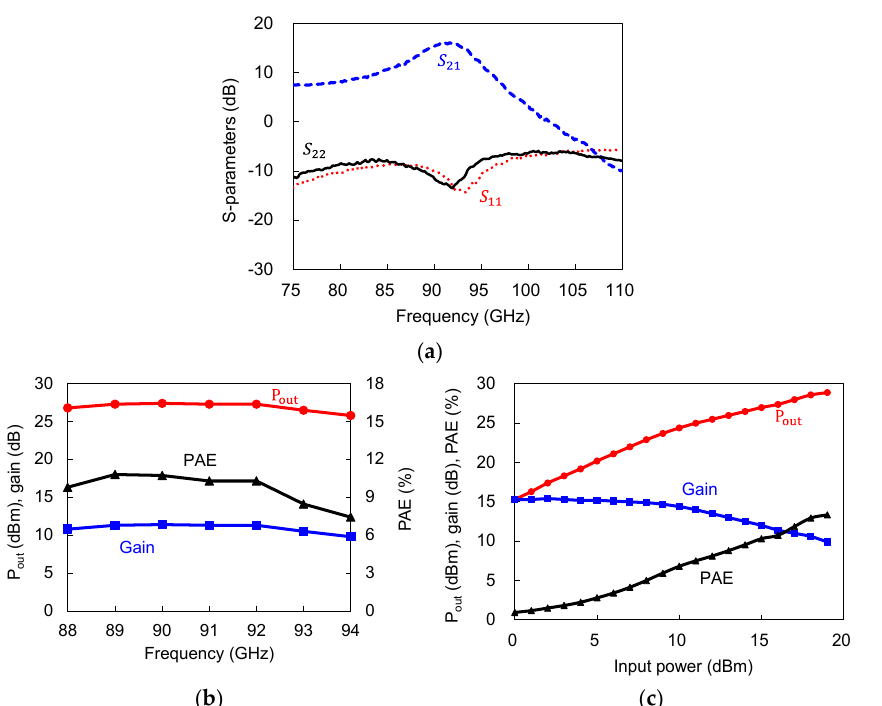
Figure 7. Measurement results. ( a ) S-parameters. ( b ) Output power, gain, and PAE versus frequency with input power of 16.0 dBm. ( c ) P out , gain, and PAE versus input power at a frequency of 90 GHz. The power measurement was performed in the continuous-wave condition. Figure 7b shows the measured output power (P out ), gain, and PAE with frequency. The input power is fixed at 16.0 dBm in this measurement. The measured P out is higher than 26.5 dBm with gain > 10.5 dB and PAE > 8.5% from 88 to 93 GHz. Figure 7c shows the measured power performance with the input power at 90 GHz. The peak power is as high as 28.9 dBm at an input power of 19.0 dBm, corresponding to the power density of 1.94 W/mm. The peak PAE was measured to be 13.3%. Figure 8 shows the performance comparison between the reported W-band GaN-on-SiC and GaN-on-Si power amplifier ICs. To the best of the authors’ knowledge, the power amplifier IC in this work presents the highest output power and power density performance among the reported GaN-on-Si power amplifier ICs operating at a W-band. It is also worthwhile to note that its output power and PAE performances are comparable to those of GaN-on-SiC power amplifier ICs, even though they are worse, as demonstrated in Figure 8.